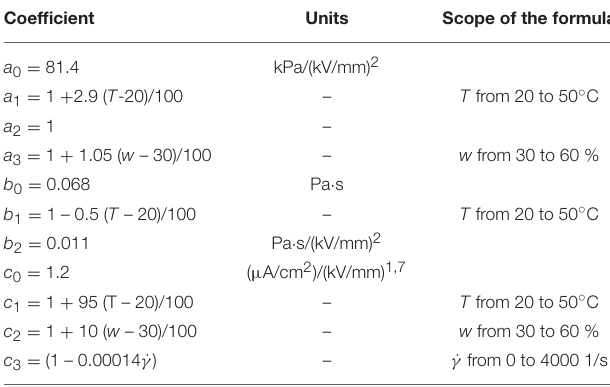
where r 2 is the radius of the cylinder connected to the lever, h is the size of the gap, M is torque, S = 2 π r 2 b is shear area, l is the length of the force arm, and b is the height of the cylinder connected to the lever.